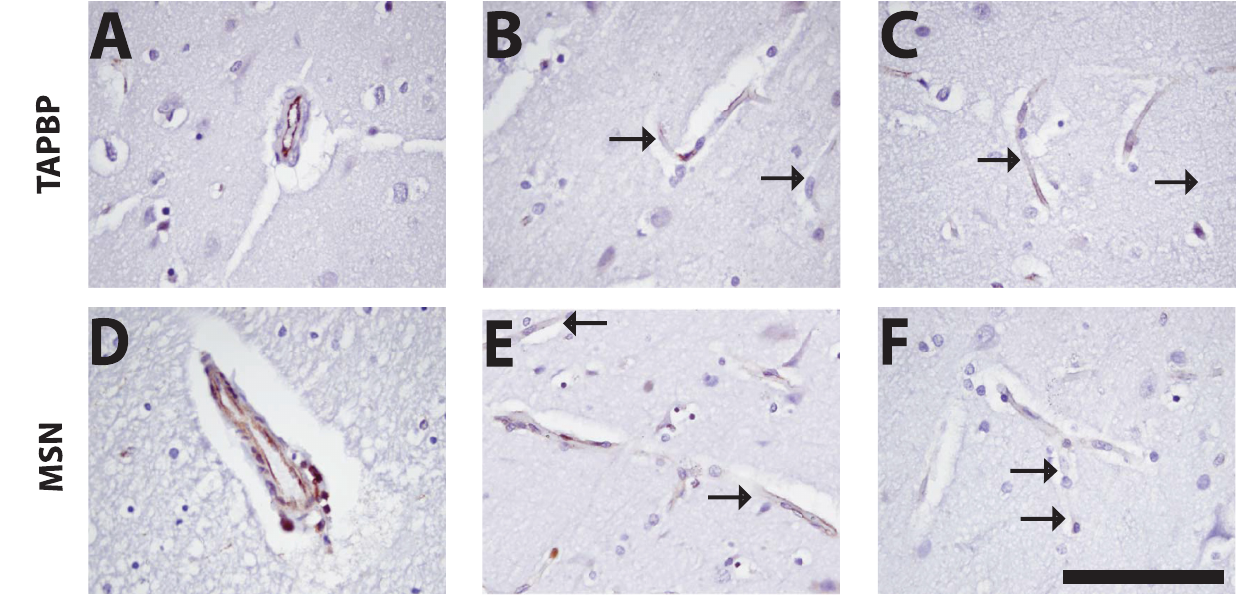
Fig 2. Heterogeneity of specific protein markersin human brain vessels. Human cortex sampleswere stainedfor TAPBP(tapasin) and MSN (moesin) to confirm intracerebral heterogeneity of marker expression. These markers showed staining in less than 85% of vessels in both Human Protein Atlas images and in validation studies performed by us. In both of these cases, EC stainingfor each protein varied from vessel to vessel, particularly in capillaries.A and D show relatively uniform expressionin EC, with MSN missing only a small numberof cells. In B, C, E and F, frequent unstainedEC were found that are highlighted with arrows. Scale bar represents 100 um and is applicableto all panels.